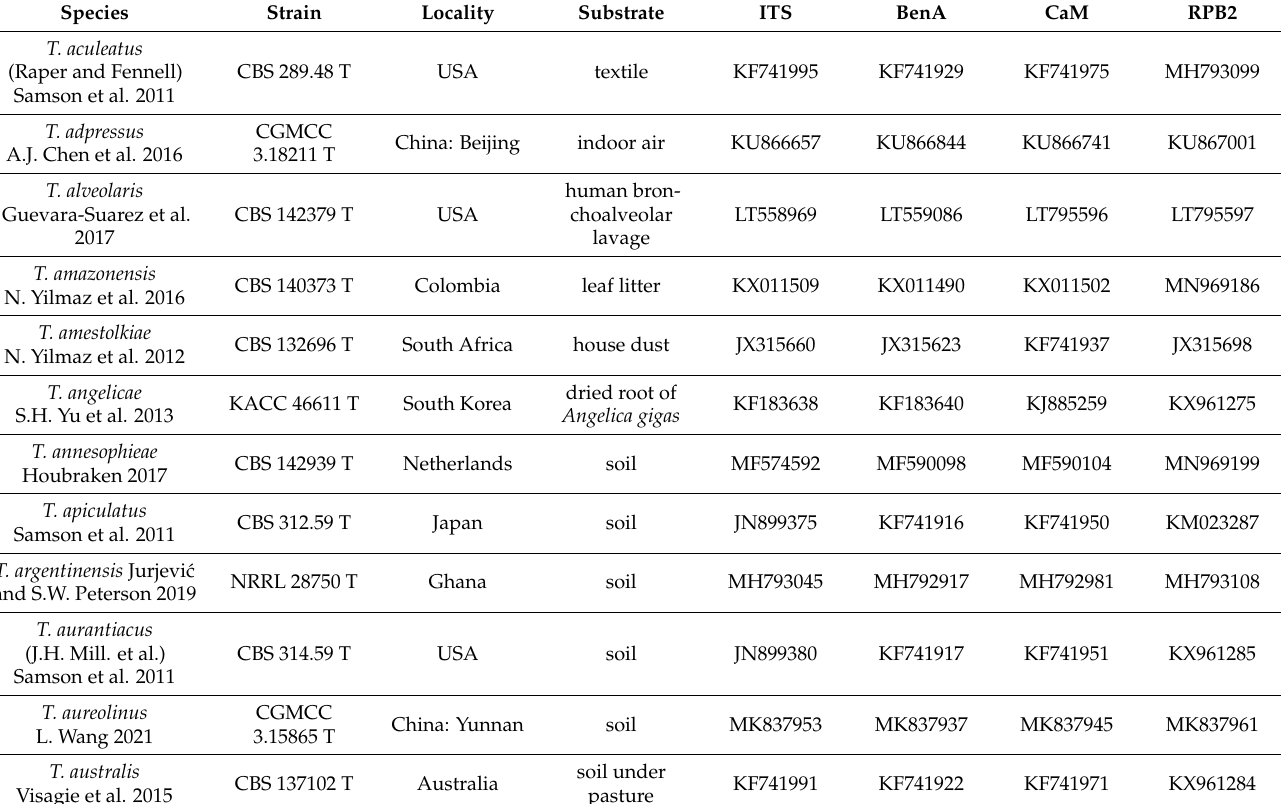
Table 2. Previously described Talaromyces species used in phylogenetic analyses of the sect. Talaromyces .